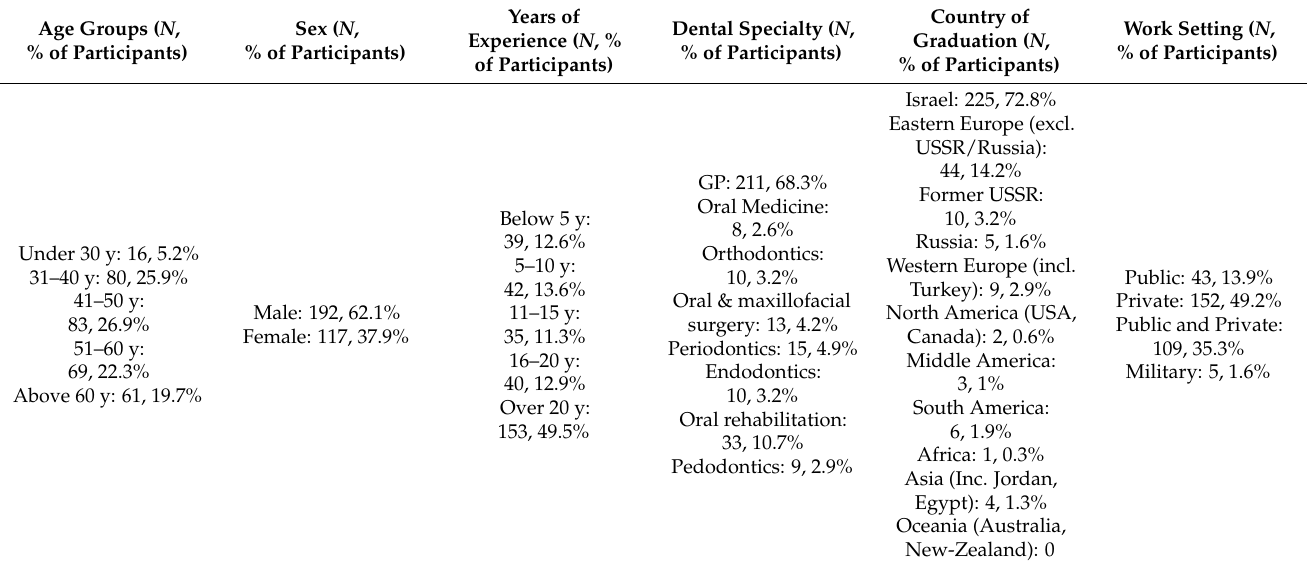
Table 1. Basic demographics of entire dental sample ( n = 309).